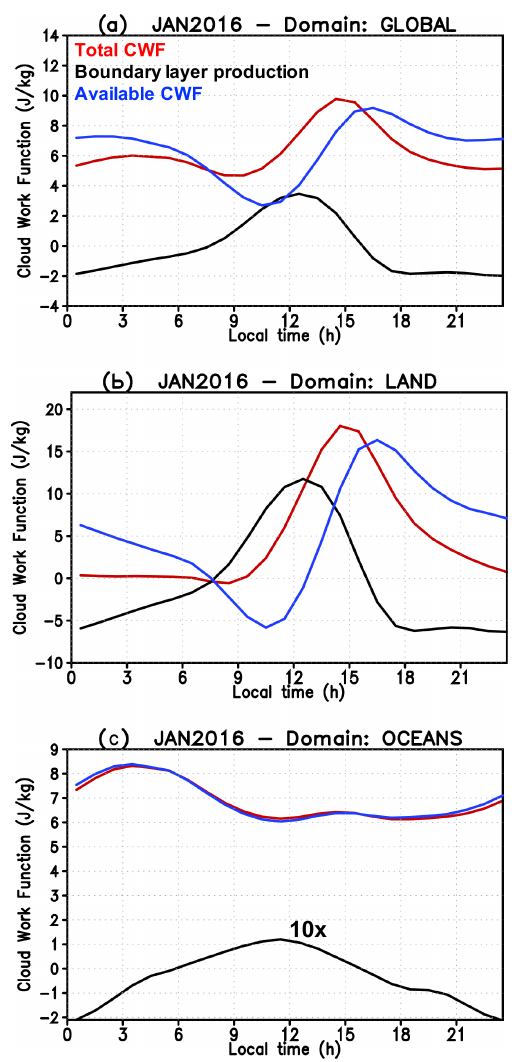
Figure 12. The monthly mean (January 2016) diurnal variation of the total cloud work function (red color), boundary layer production (black), and available cloud work function (blue). The curves also represent the areal average over (a) the entire globe, (b) the land re- gions, and (c) the oceans. In panel (c) the boundary layer production is multiplied by 10 for